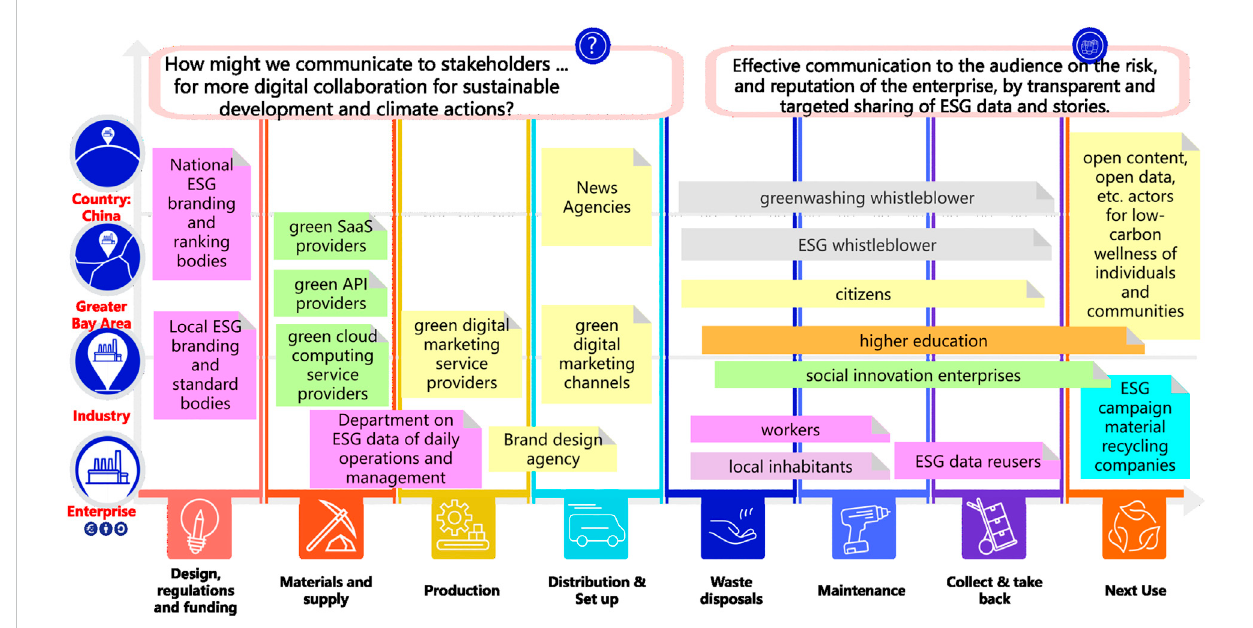
FIGURE 3 Partner map for ESG communicating (based on the blank canvas provided by Circulab (2020) through Creative Commons License Attribution- NonCommercial-ShareAlike 4.0